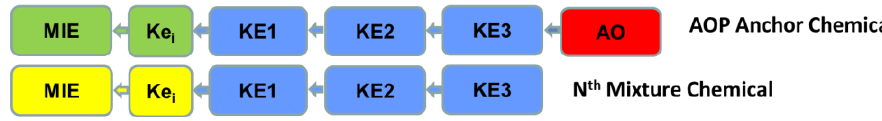
Figure 2. General Adverse Outcome Pathway (AOP) footprint process. For each individual AOP identified in step 4, in step 5, ‘footprinting’ entails the systematic retrograde evaluation of key events between an AOP anchor chemical and other members of the specific AOP grouping. The most downstream key event (i.e., most proximal to the adverse outcome [AO]) that is shared between the AOP anchor chemical and group members and has available dose-/concentration-response data, is identified as a candidate AOP ‘footprint’. It should be noted that although the hypothetical AOP shown is tabular/linear in sequence, for simplicity of interpretation, in practice there will likely be diversity in KEs the further upstream (i.e., toward earlier KEs and the MIEs) one moves up a given AOP.